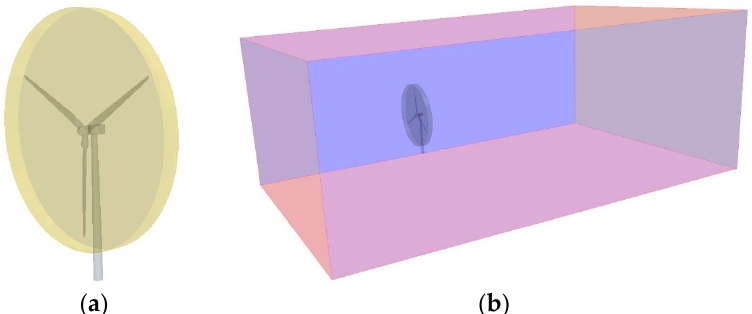
Figure 1. Rotating and outer domain: ( a ) rotation domain for wind turbine simulation; ( b ) entire computational domain for numerical simulation.